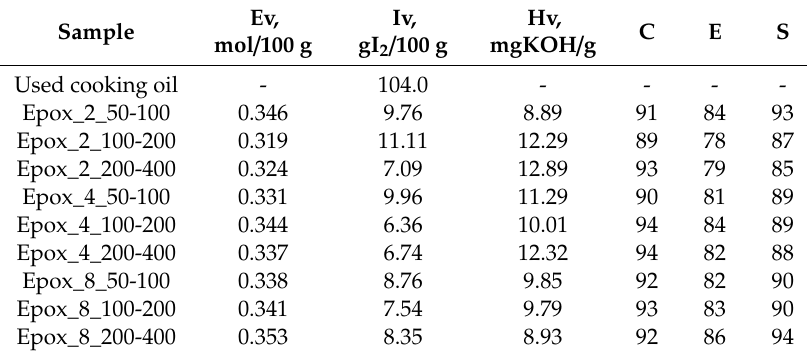
Table 3. Characteristics of epoxidized oil obtained using di ff erent